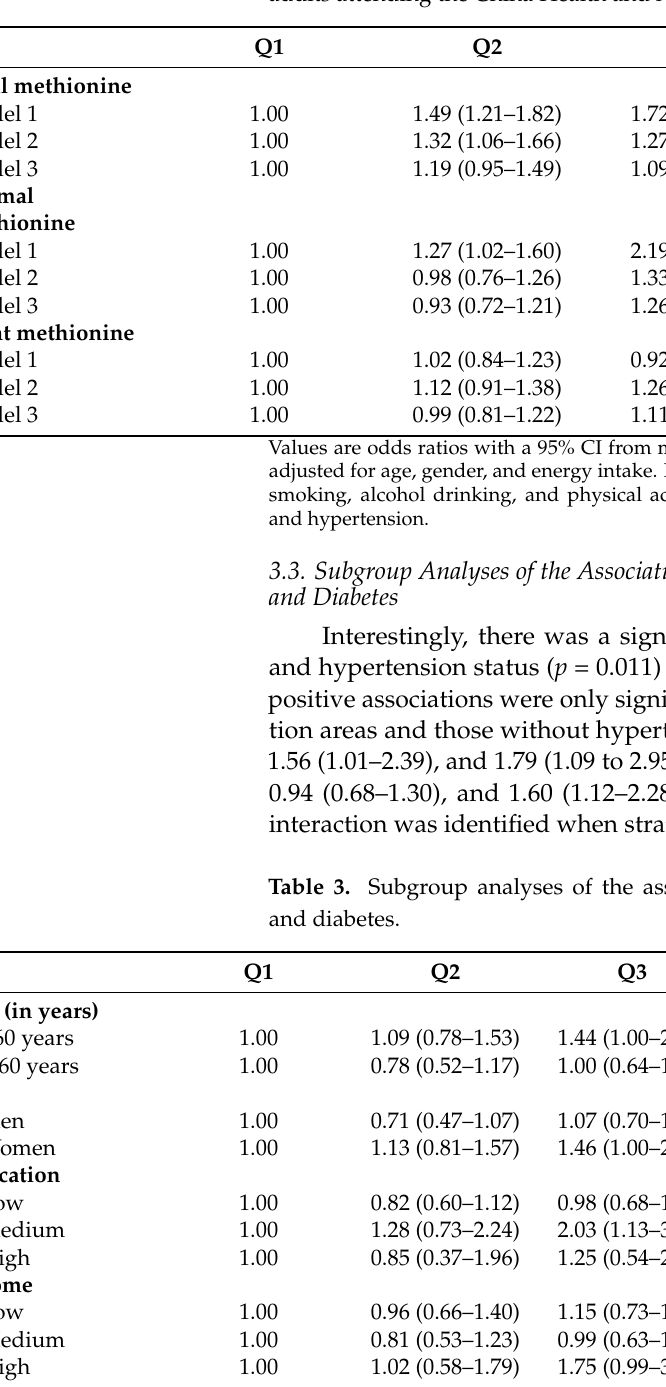
Table 2. The association between total, animal, and plant methionine intake and diabetes among adults attending the China Health and Nutrition Survey.